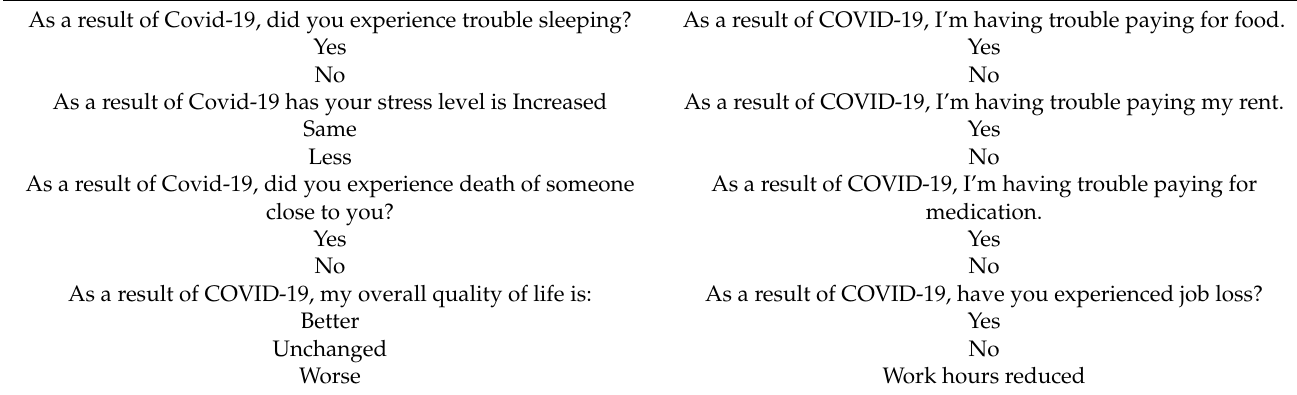
Table 1. Psychosocial and behavioral